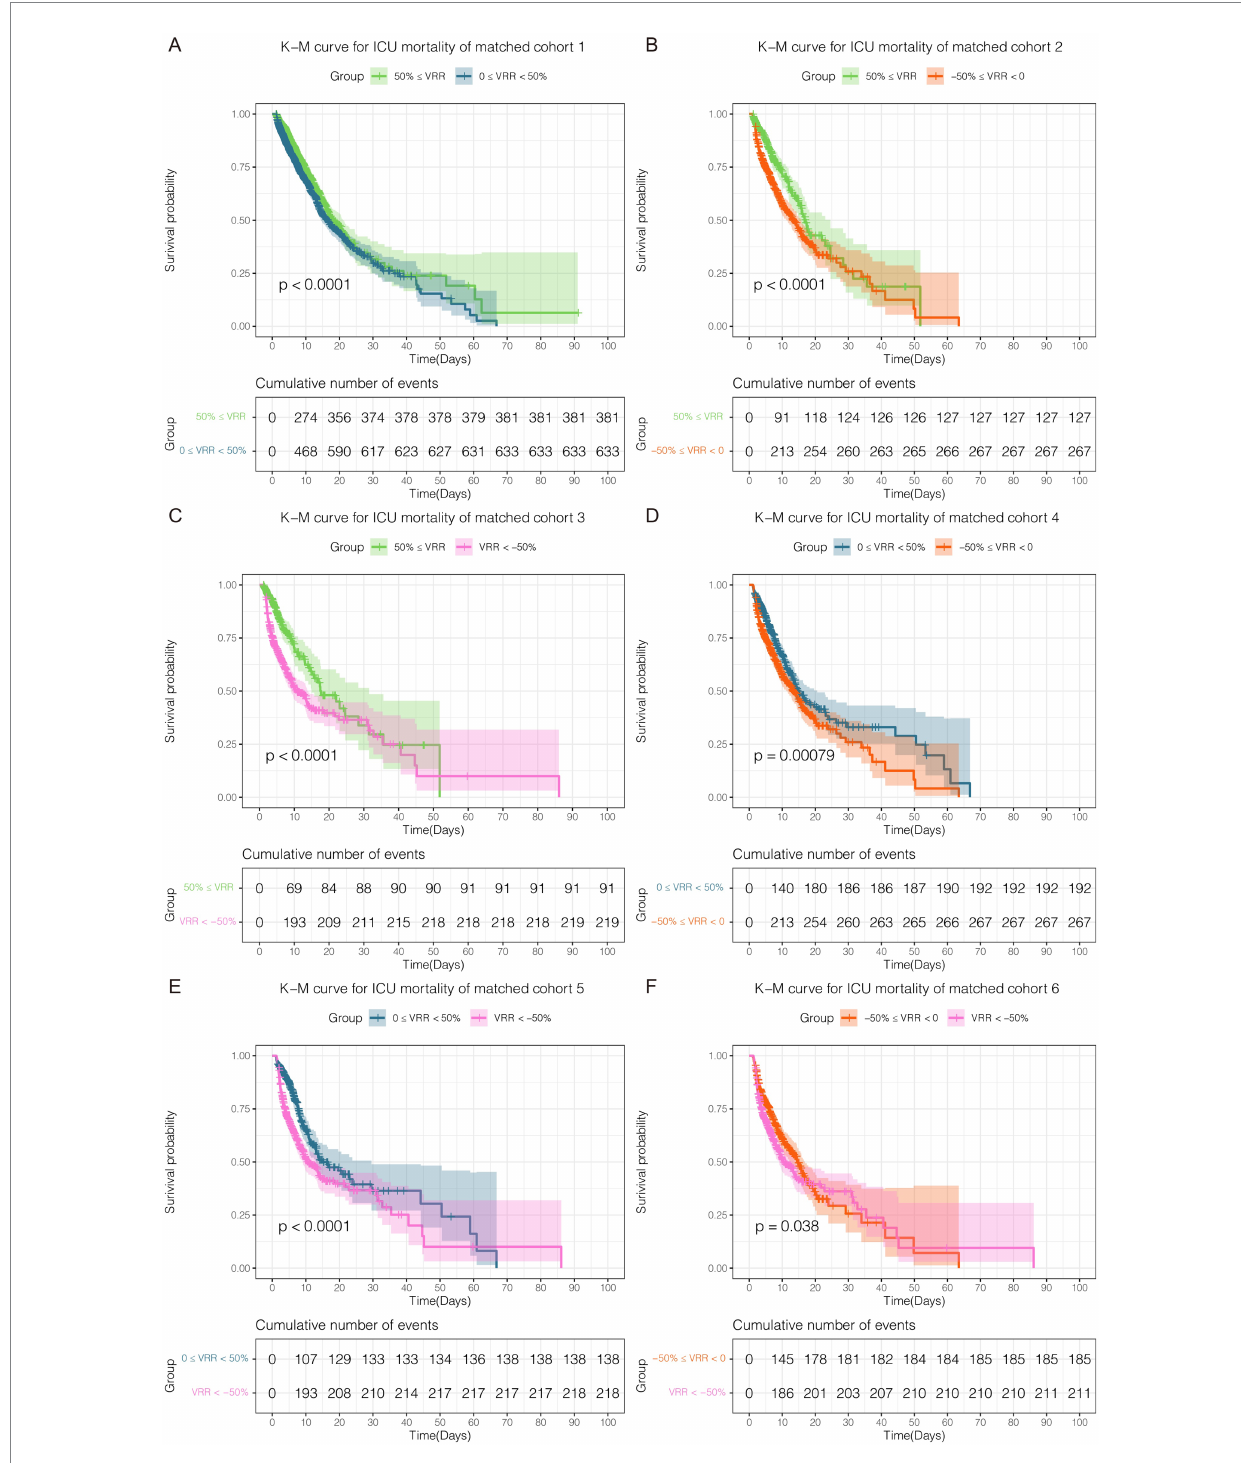
FIGURE 4 Kaplan–Meier curve for ICU mortality in each cohort (A–F) after pairwise PSM. The differences for each matched cohort were